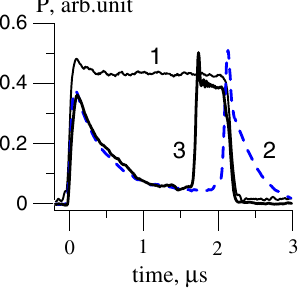
FIG. 5. (Color) Oscillograms of the incident (1) and reflected (2—without multipactor, 3—with multipactor) microwave pulses.